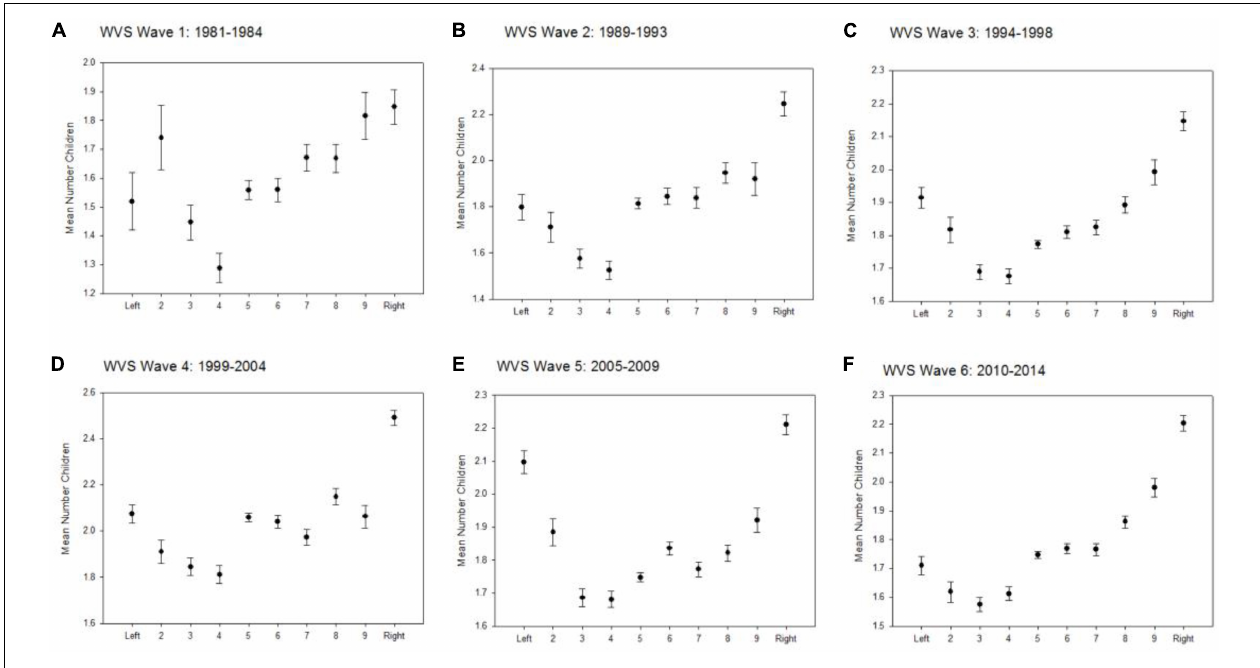
FIGURE 2 | (A–F) Political attitude and mean ( ± SE) number of children separately for each WVS wave.